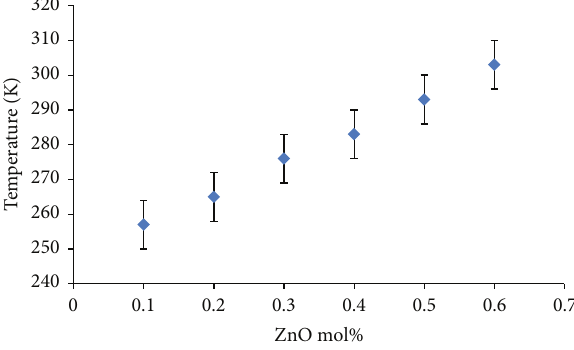
Figure 6: Variation of Debye temperature versus ZnO